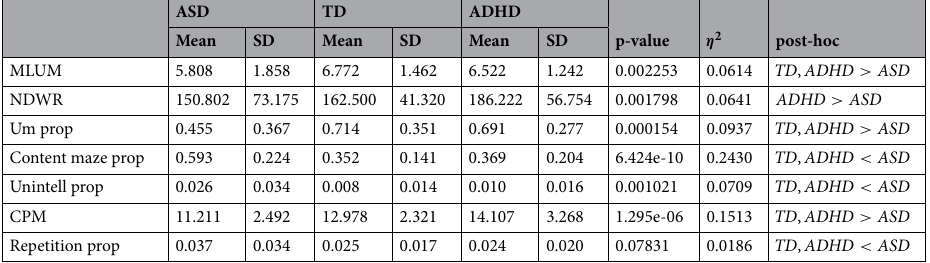
Table 3. Diagnostic group differences for ALMs. P-value determined by Kruskal-Wallis test. Eta-squared ( η 2 )